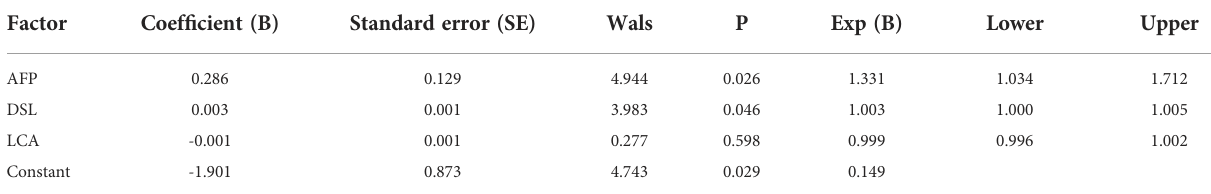
TABLE 3 Results of the developed binary logistic regression model in HCC and NC of